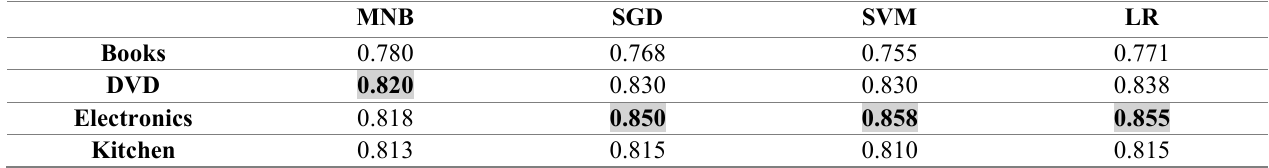
Table 5. In-domain classification results using manual labeling